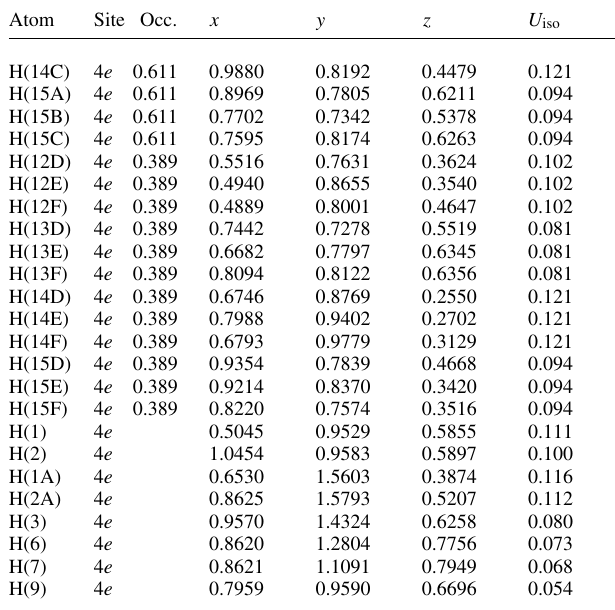
Table 2. Continued . Table 1. Data collection and